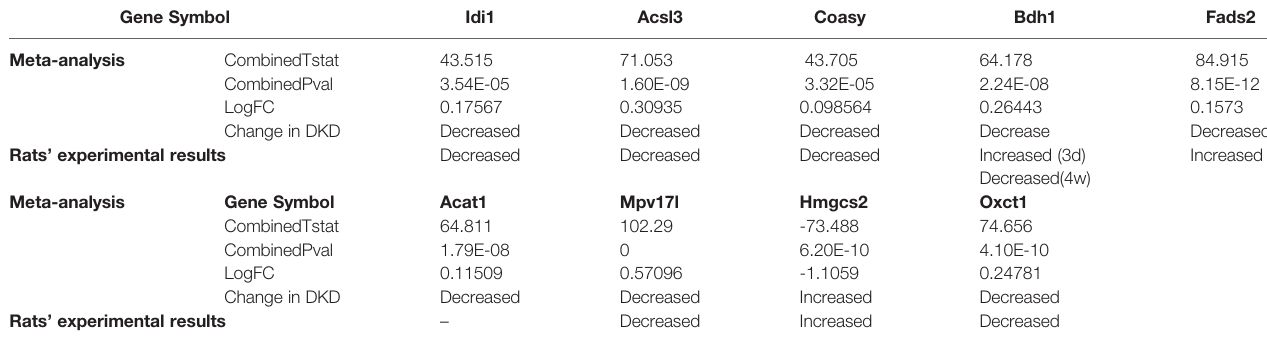
TABLE 4 | Meta-analysis details and experimental results of the shared hub genes unpublished relative to DKD and DEGs of interest in T1DKD rats. Gene